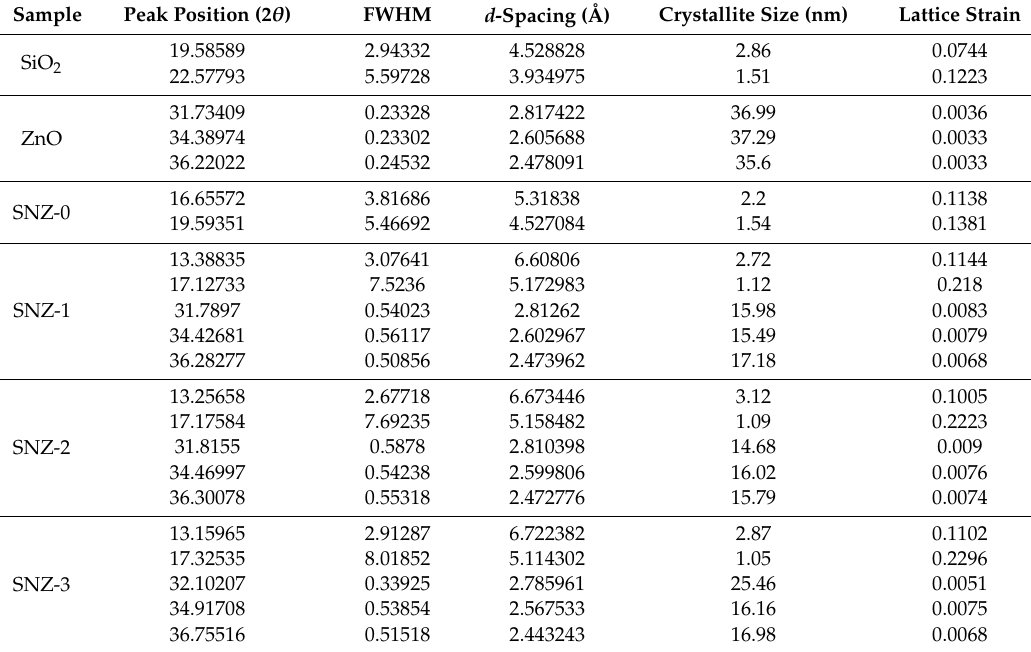
Table 2. XRD peak parameters of the